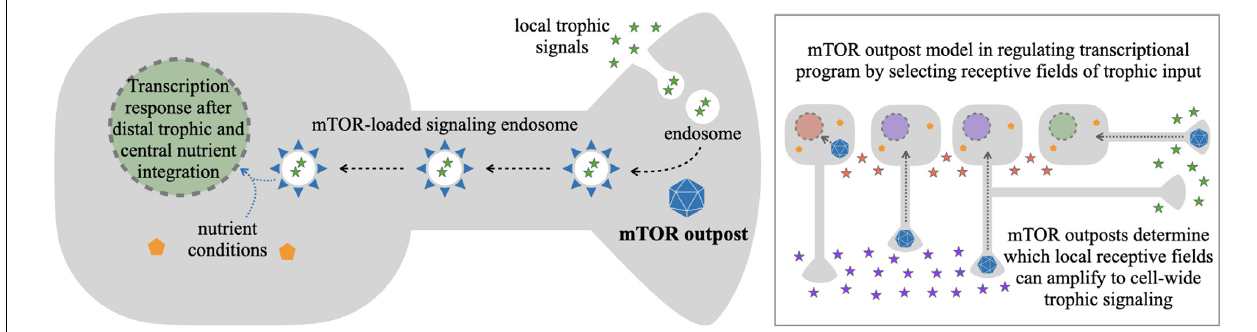
FIGURE 3 | mTOR outpost model in gating local trophic signals reaching the nucleus. Local trophic signals, such as NGF in development and BDNF in adulthood, are dynamically and locally present at different regions of a projection neuron’s plasma membrane. Endocytosis at those regions can lead to endosomes with internalized trophic signals bound to their cognate receptors on the endosome membrane. In those regions that additionally contain a local mTOR outpost (blue polyhedron), mTOR and associated proteins (blue triangles) from the outpost are recruited to local late endosomes leading to putative signaling endosomes with ligand, receptor, and mTOR-quipped transduction apparatus. Signaling endosomes can be transported retrogradely to the cell body, bringing mTOR-dependent trophic signaling to the vicinity of the nucleus. As such, the location of an mTOR outpost would function as a permissive gate to bring distal trophic signals from the periphery towards the regulatory center of the cell, where information on central nutrient conditions could be integrated through activation of mTOR on the signaling endosome. With selective mTOR outpost localization, this would allow neurons to respond transcriptionally to select local or distal signals (various color stars in inset) from select branches of neurites. This would make localization of mTOR outposts in the soma, dendrites, axons, or sub-branches in those compartments, determine critical modes of cellular transcriptional responses to